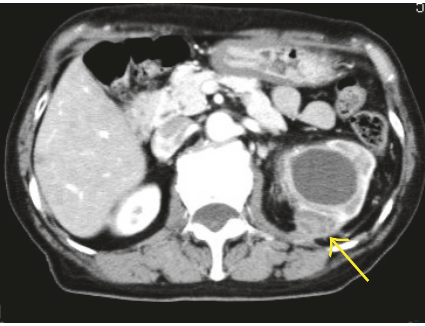
Figure 1: CT image: left renal mass with contrasted surface (arrow).